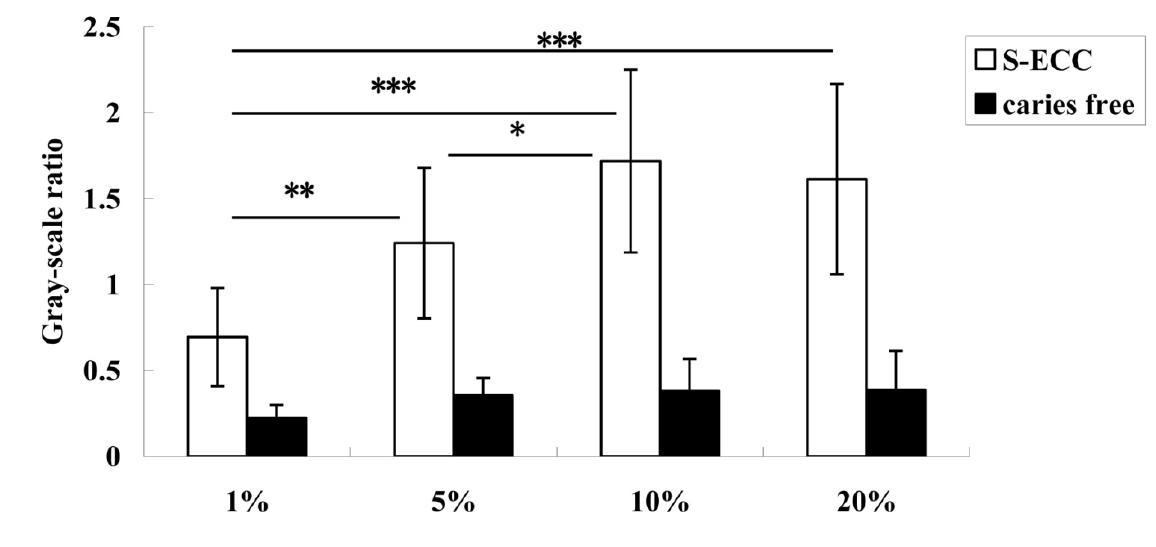
Figure 3. The expression of gtfC in S. mutans from children with ECC and caries-free children when the sucrose concentration was 1%, 5%, 10%, and 20%. The expression level of gtfC increased significantly when the sucrose concentration was 1% to 10%, and the 1% group expression was significantly lower than in the 5%, 10%, and 20% groups. * Denotes statistical significance ( p < 0.05), ** Denotes statistical significance ( p < 0.01), and *** Denotes statistical significance ( p < 0.001).